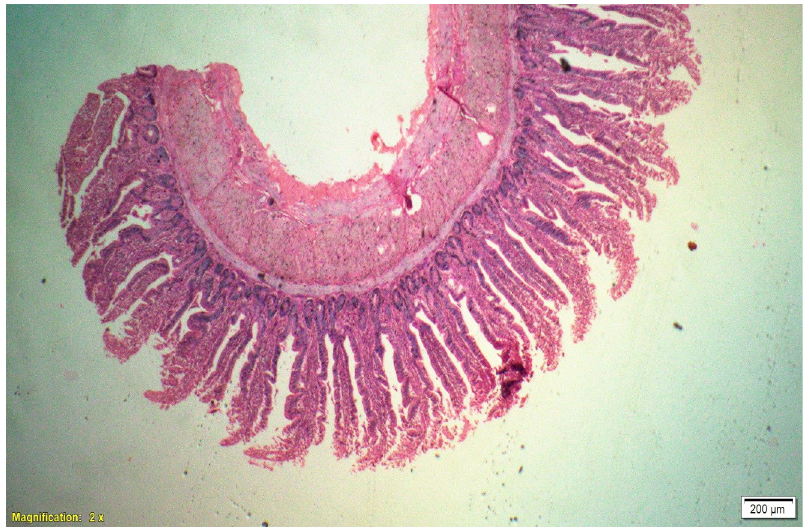
Fig 7. Photomicrograph of the cross section of ileum from control group (T1). H&E, 2x.